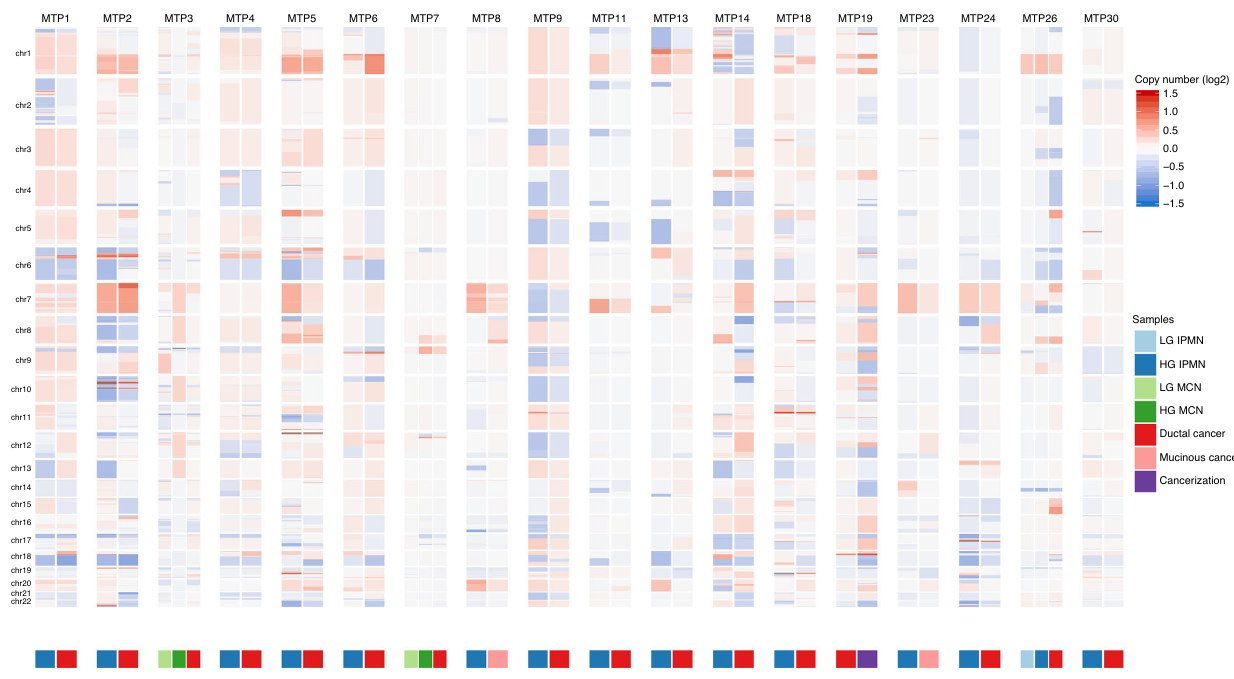
Fig. 2 Copy number alterations identi fi ed in matched noninvasive and invasive cancer samples. Chromosomal gains (red) and losses (blue) are shown for each chromosome in each patient, with noninvasive samples on the left and cancer samples on the